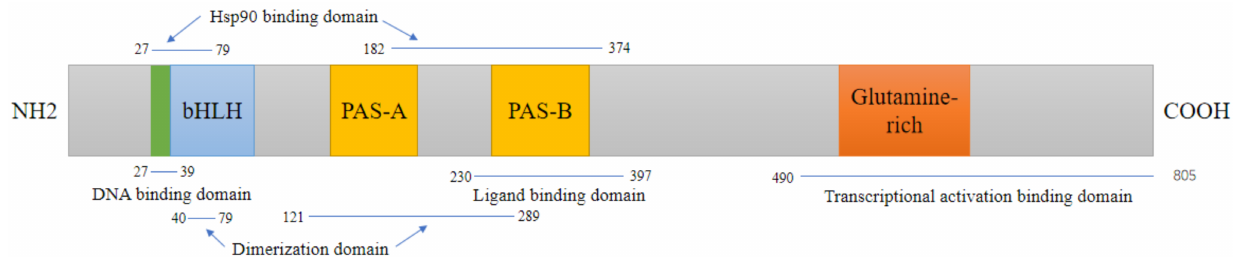
Figure 1. Domain structures of mouse AhR. The AhR protein contains several critical domains. DNA binding domain:The basic region helix–loop–helix (bHLH) aids in binding the transcription factor to DNA and protein–protein interactions; Ligand binding domain: PAS B domain along with flanking amino acid residues on both sides, serves as ligand-binding domains, and mediates interactions with several other proteins;. Transcriptional activation binding domain: In the C-terminal region, a glutamine-rich domain is involved in coactivator recruitment and